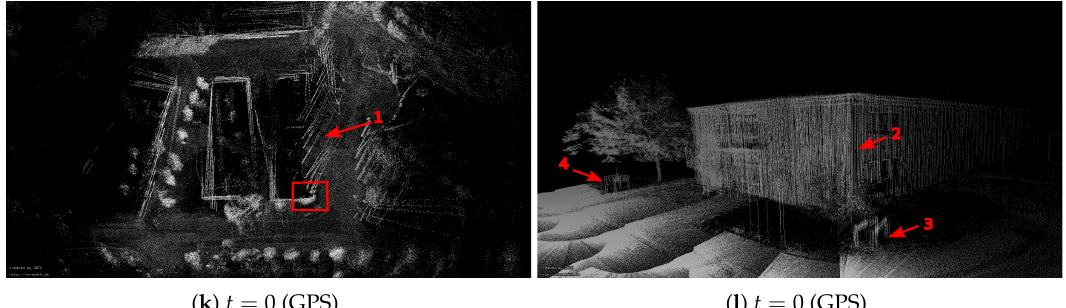
Figure 6. Visual inspection of the ZAE data sets. Left column: 3D point cloud results from bird’s eye view. Right column: the corresponding perspective views. The right column shows perspective views that correspond to the areas marked with red rectangles in the left